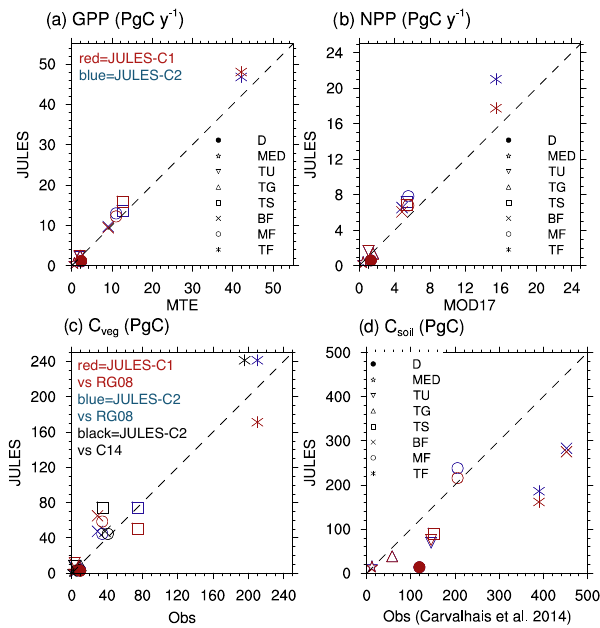
Figure 5. Biome-averaged (a) GPP, (b) NPP, (c) C veg , and (d) C soil in JULES-C1 and JULES-C2 (both with CRUNCEP-v6 climate) compared to observations. The observation sources are the same as in Fig. 4 except (c) compares the C veg from Ruesch and Gibbs (2008) (“RG08”) to that from Carvalhais et al. (2014) (“C14”, black shapes). The biomes are as follows: tropical forests (TF); temperate mixed forests (MF); boreal forests (BF); tropical savan- nah (TS); temperate grasslands (TG); tundra (TU); Mediterranean woodlands (MED); and deserts (D) (biomes in Fig. S9). Grid cells with > 50% agriculture have been excluded from the biome aver-